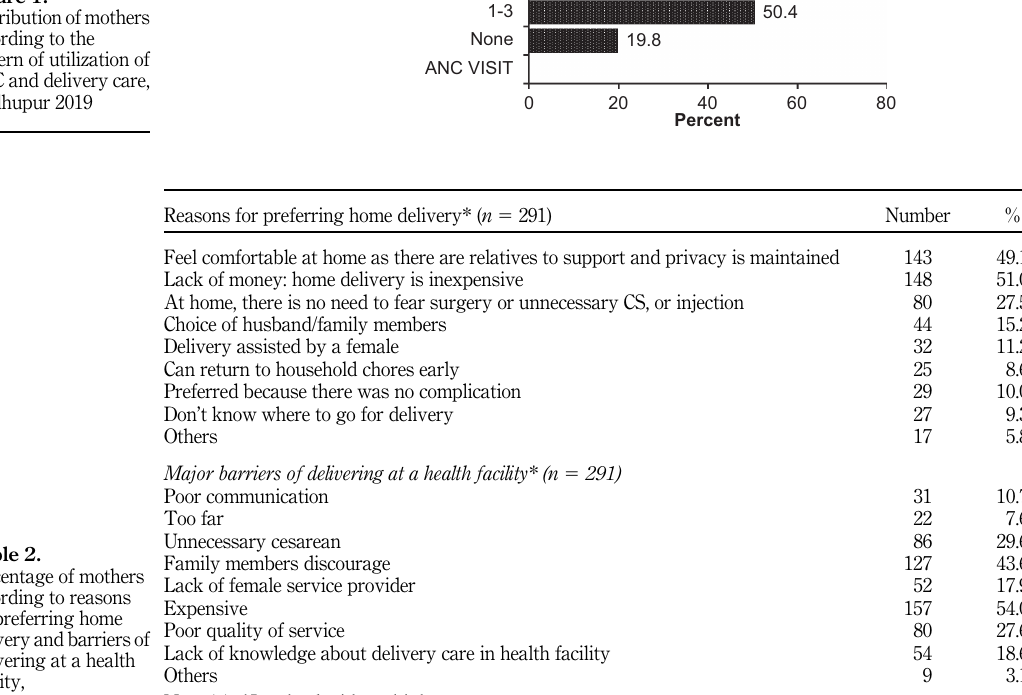
Table 2. Percentage of mothers according to reasons for preferring home deliveryandbarriersof delivering at a